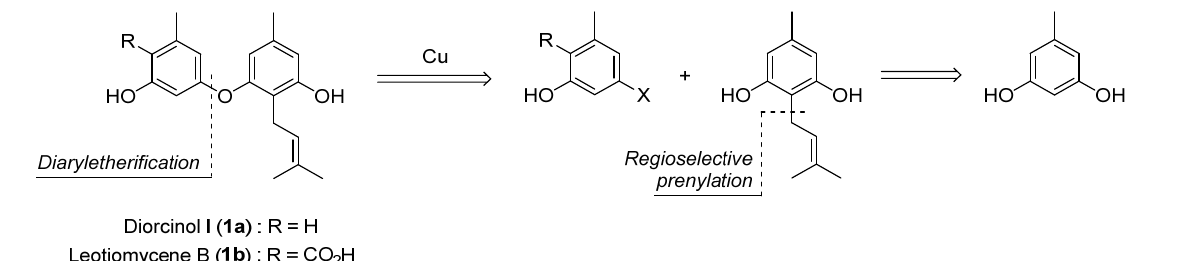
Figure 2. Retrosynthetic analysis of diorcinol I and leotiomycin B.